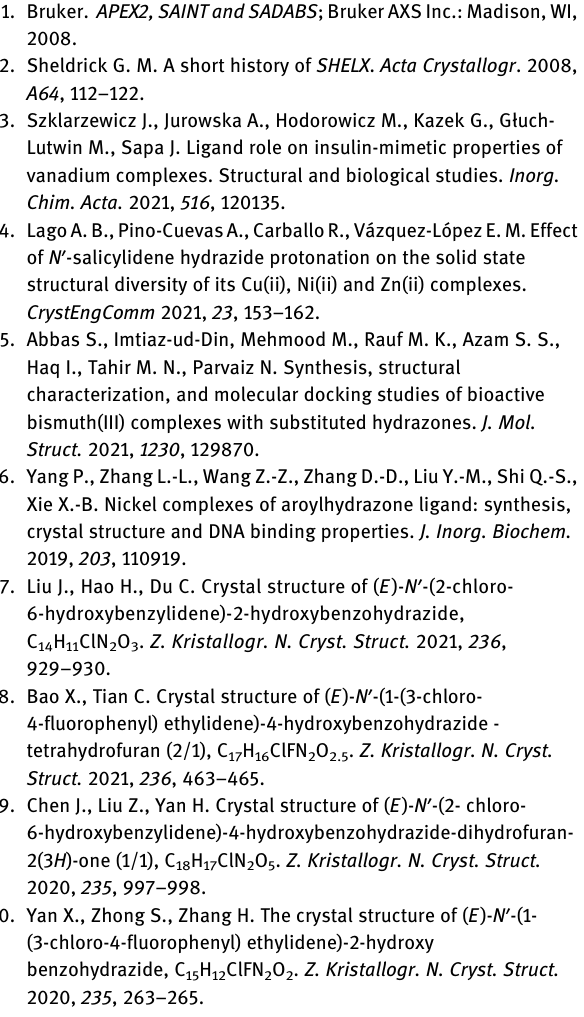
The bond length of this double bond is with the distance d (C8 – N2) of 1.278(4) Å in the normal range. The C8=N2 – N1 angle of 119.5(3) ° is very close to the ideal value. The two aromatic rings form a dihedral angle of 13.29 ° . In the crystal structure, O – H···O and N – H···O hydrogen bonds link the molecules into two-dimensional networks in the ac plane. In addition, intramolecular O – H···N hydrogen bonds further consolidate the structure.